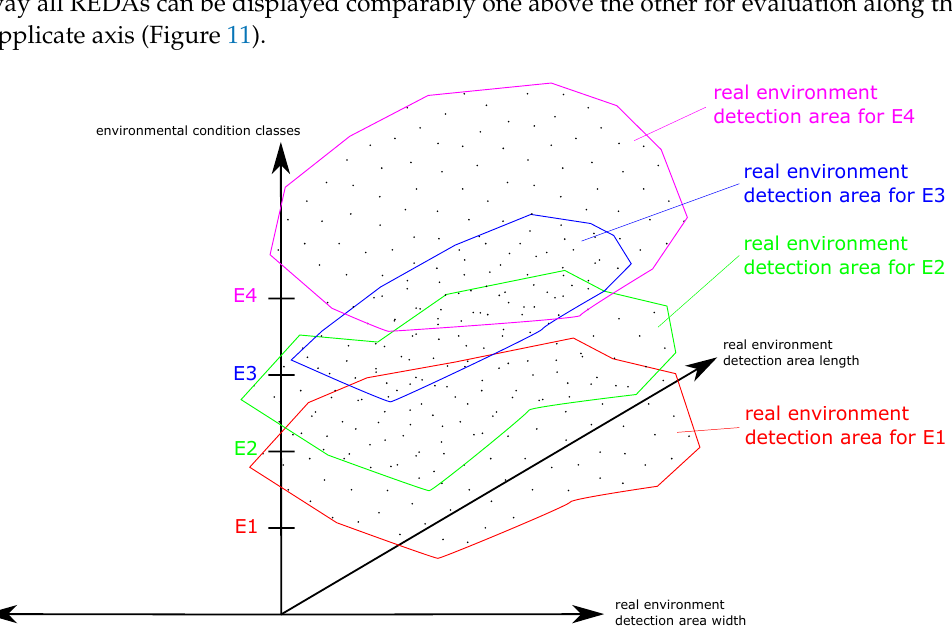
Figure 11. A real environment detection area matrix (REDAM) describes the detection capability of an ODS over all tested environmental conditions (E1–E4). All REDAs can be displayed comparably one above the other for